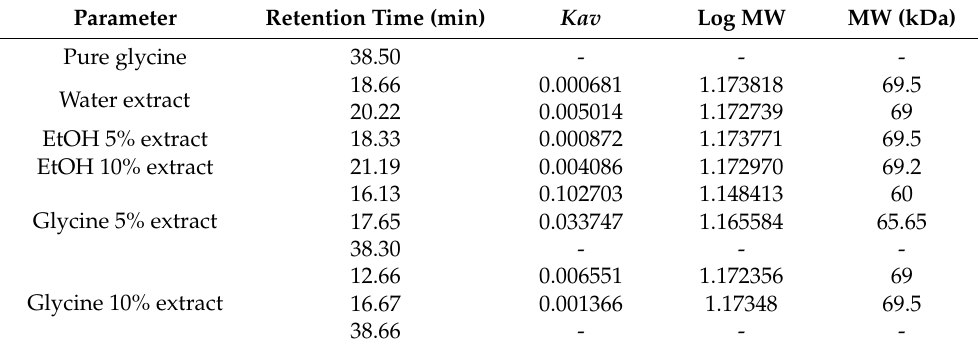
Table 2. Molecular weight distribution in